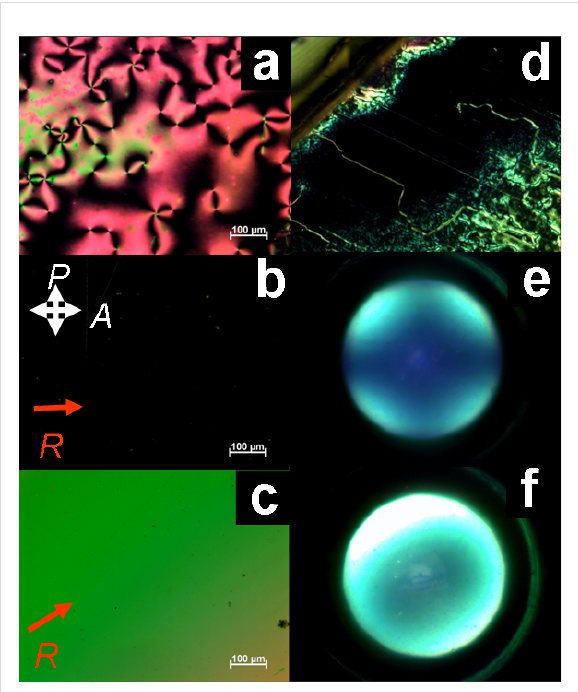
Figure 5: Textures of the nematic phase of 2c . a) Schlieren texture at 173 °C. b) and c) Planar alignment on rubbed polyimide at 167 °C (R = rubbing direction). d) Homeotropic aligned area of 2c on glass at 163 °C. e) Conoscopic picture at 161 °C and f) Conoscopic picture using the circular